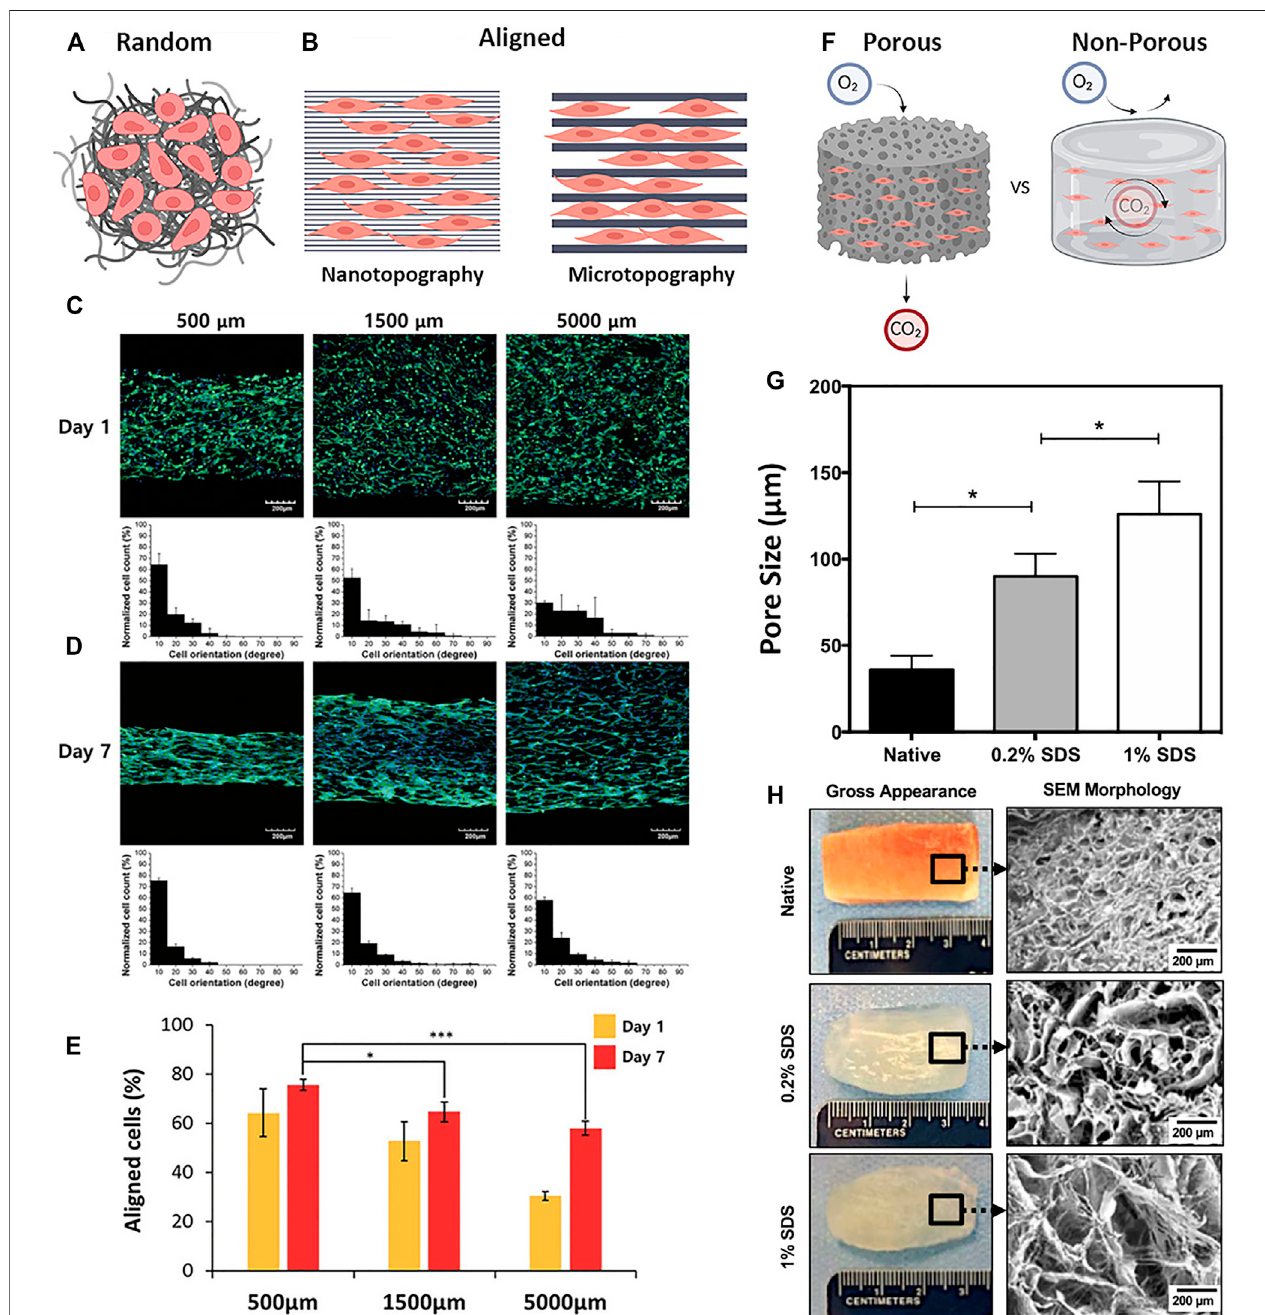
FIGURE 5 | Patterning and topography in dECM biomaterials (A) Material topography with a random-orientation of fi bers and cells (B) Nano- and micropatterned materials withparallelorientation of fi bers orchannels showing differences in cellguidance and interaction (C – E) C2C12 myoblastsculturedon 3D-printed linewidths of 500 μ m, 1,500 μ m, and 5,000 µm on (C) day 1 and (D) day 7 ; cells were stained green for F-actin (Phalloidin), and blue for nuclei (DAPI) (E) Quanti fi cation of % aligned cells on the varying line widths at day 1 and 7 (F) Porous and Non-Porous properties of bulk materials differentially regulatethe diffusion of gases and other soluble factors (G) Quanti fi cation of average pore sizes in native skeletal muscle tissue and decellularized scaffolds treated with 0.2% SDS and 1% SDS, respectively (H) MacroscopicandSEMimages ofnativeskeletalmuscleanddecellularizedscaffoldstreatedwith0.2%SDSand1%SDS,respectively. FiguresA,B,Farecreated using BioRender.com. Figures C – E are adapted with permission from Choi et al. (2016). Figures G, H are adapted with permission from Shapiro et al. (2019).